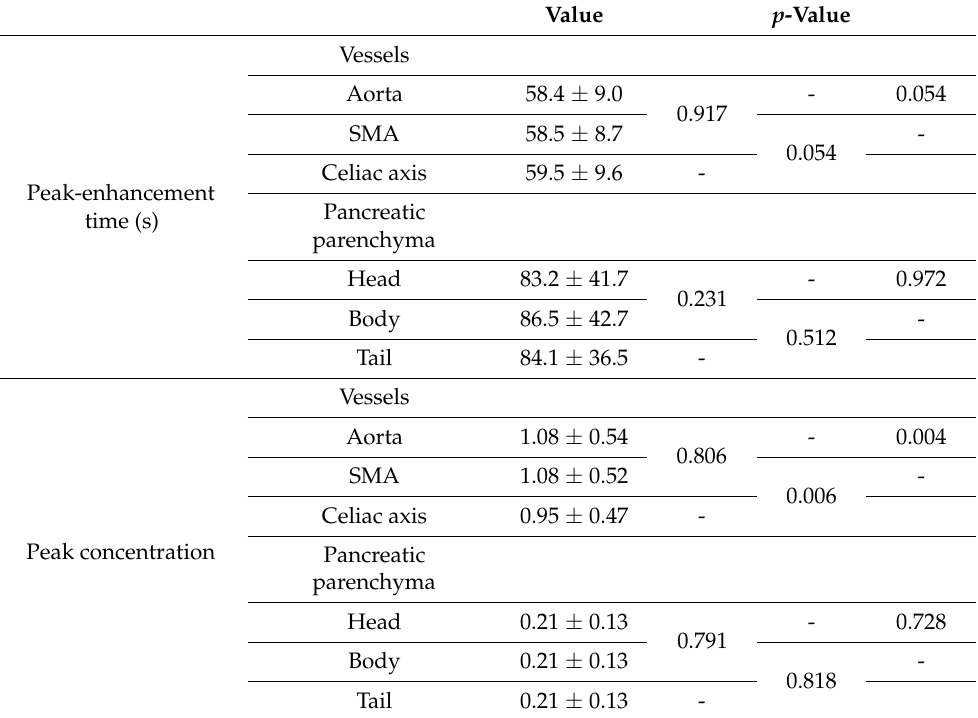
Table 4. Peak-enhancement time and concentration in the vessels and pancreatic